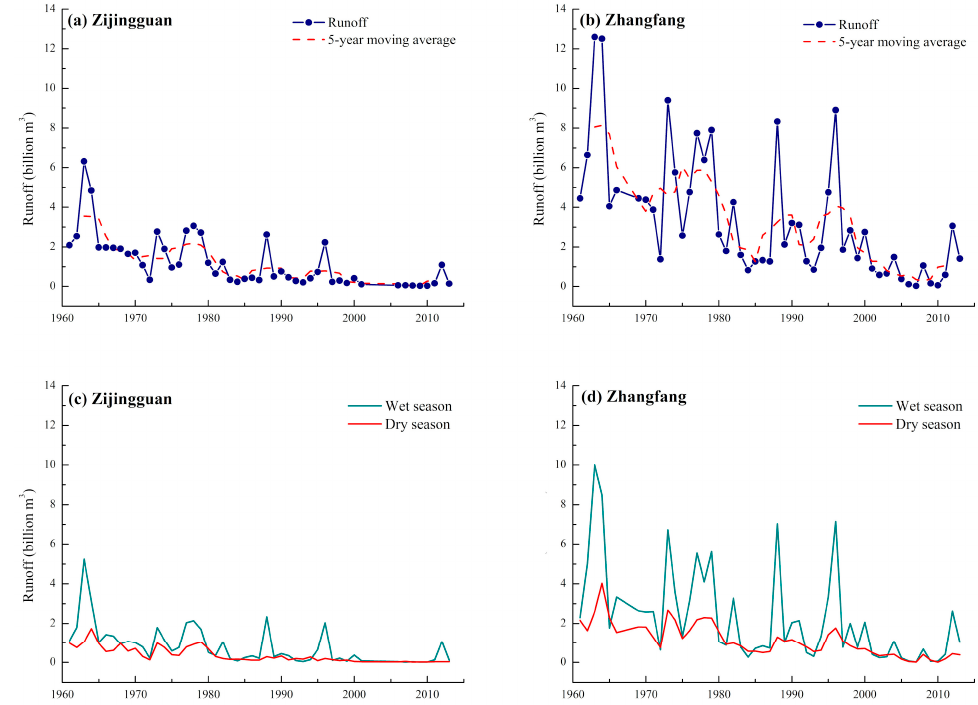
Figure 4. Time series of measured runoff for two stations during 1961–2013.